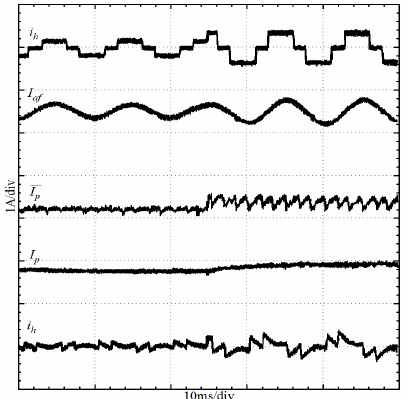
Figure 6. Prototype object.